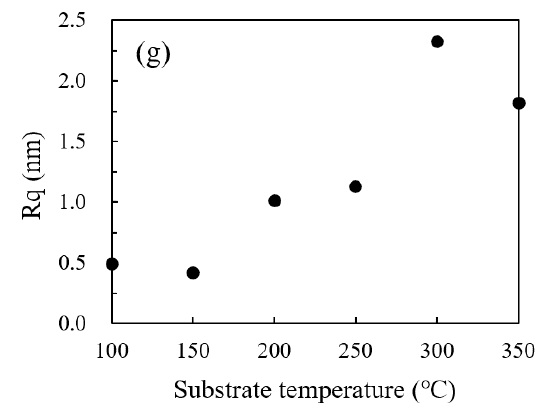
Figure 6. Three-dimension atomic force microscopy (AFM) images of PEALD-In 2 O 3 films deposited at a substrate temperature of ( a ) 100 °C; ( b ) 150 °C; ( c ) 200 °C; ( d ) 250 °C; ( e ) 300 °C; and ( f ) 350 °C; ( g ) the variation of root-mean-square roughness ( R q ) of the PEALD-In 2 O 3 films with substrate temperature.